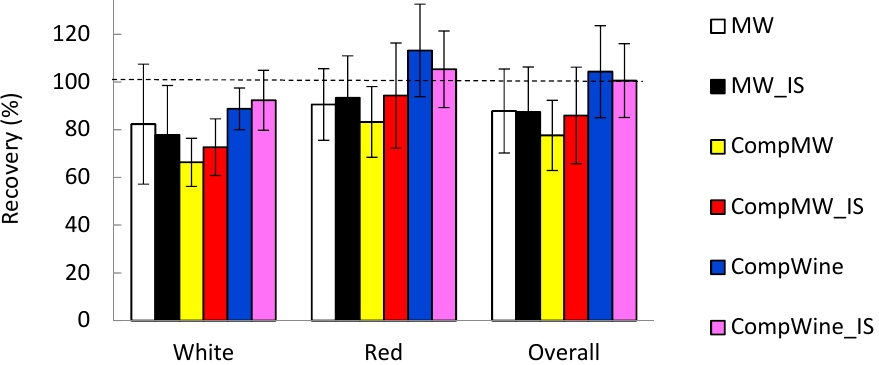
Figure 4. The recovery of 0.04 mg/L Cu in wines by the different quantitation methods. The error bars represent the standard deviation (n = 5 for white wines, n = 7 for red wines and n = 12 for overall wines).